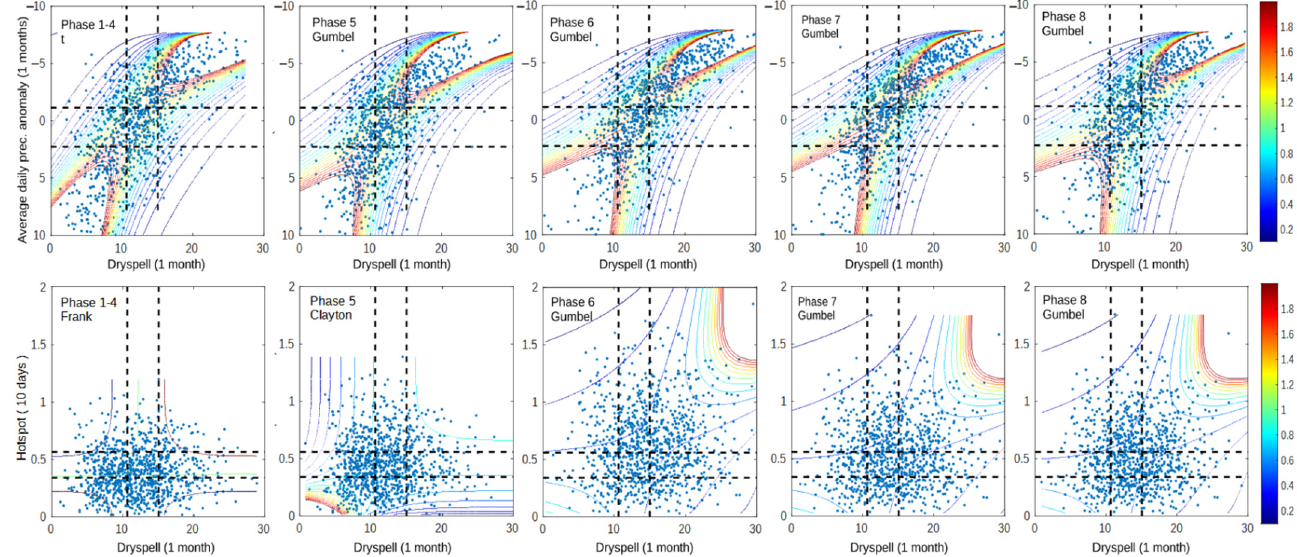
Figure 11. Dependency graph of dry spell–prec. anomaly and dry spell–hotspot for 2001–2020 data. The dashed lines represent the separation of wet ( bottom / left ), normal ( middle ), and dry ( up / right ) conditions for dry spell (vertical line) and hotspot (horizontal line).